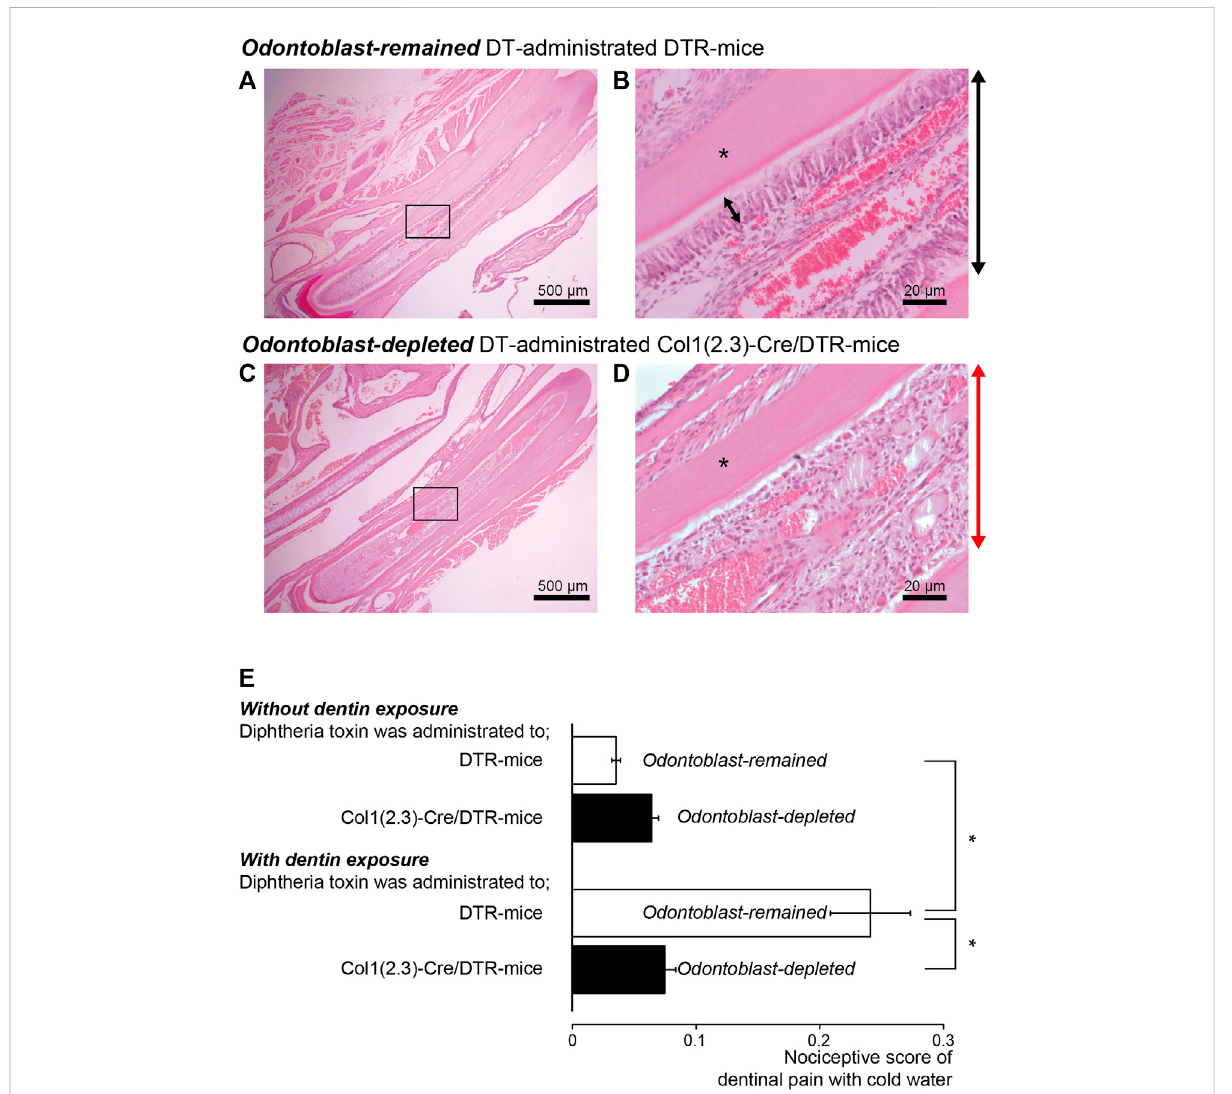
Reduction in nociceptive scores in dentin-exposed mice with odontoblast-speci fi c depletion by somatic Cre-mediated gene recombination (A,B) Morphological observations revealed highly polarized odontoblast arranged at the dentin-pulp border in DTR-mice. (C,D) In Col1 (2.3)-Cre/ DTR-mice exhibiting somatic odontoblast-speci fi c depletion upon administration of diphtheria toxin (DT), we could not observe highly polarized odontoblast arranged at the dentin-pulp border. Bars indicate 500 μ m in (A,C) , and 20 μ m in (B,D) . Images in (A – D) were obtained from both miceafter1 weekof250 ngDTintraperitonealinjectionevery24 h.Photosof (B,D) showtheareasshownbysquaresinAandC. (E) Bargraphshows nociceptive scores following cold water stimulation without (uppertwo columns) or with (lower twocolumn) dentin-exposurein control DTR-mice (open columns; n = 8) and odontoblast-de fi cient Col1 (2.3)-Cre/DTR-mice ( fi lled column; n = 8). Each bar shows the mean ± S.E. Signi fi cant differences between columns (shown by solid lines) are denoted by asterisks: * p <